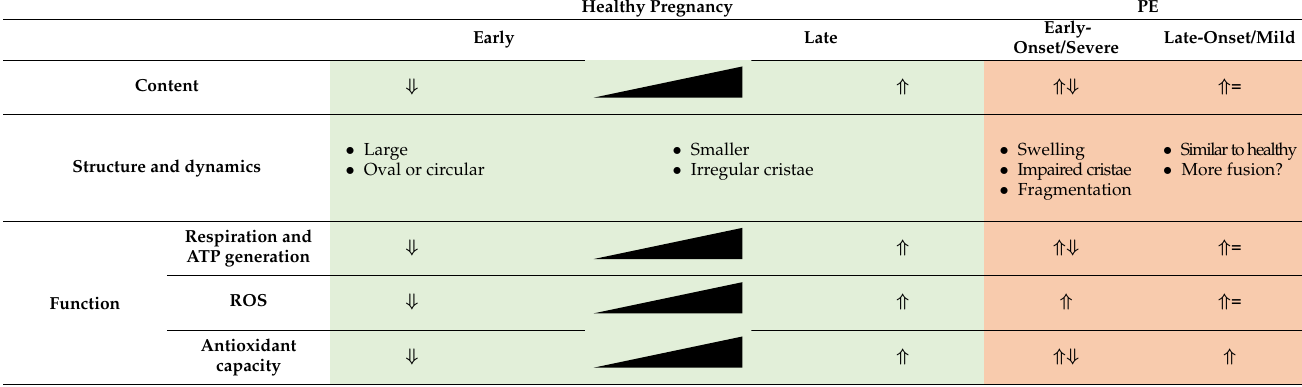
⇑ ⇑⇓ ⇑ In healthy pregnancy, comparison was between early and late gestation. In PE-complicated pregnancy, comparison was with healthy term or preterm pregnancy. The symbol “ = “ was used when the finding was similar to healthy control. The symbol ↑ indicates increase and ↓ indicates